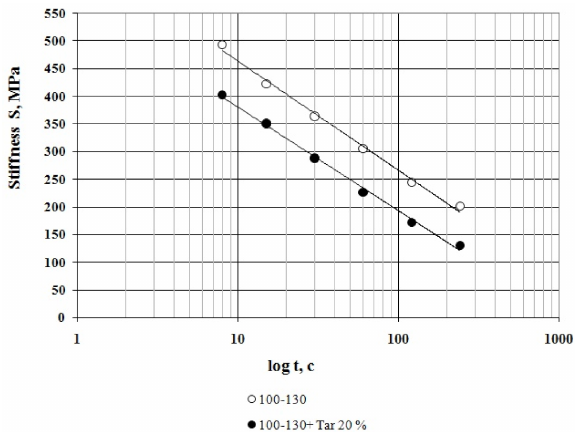
Figure 6. Stiffness variation of the virgin bitumen and the compounded one (20% of the tar) in time at the temperature of − 36 ◦ C.